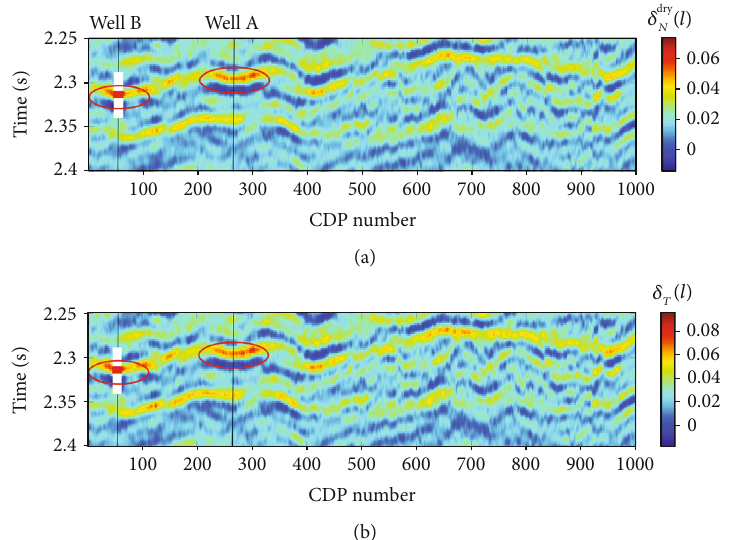
Figure 11: Estimated fracture parameters, where (a) is the normal fracture weakness and (b) is the tangential fracture